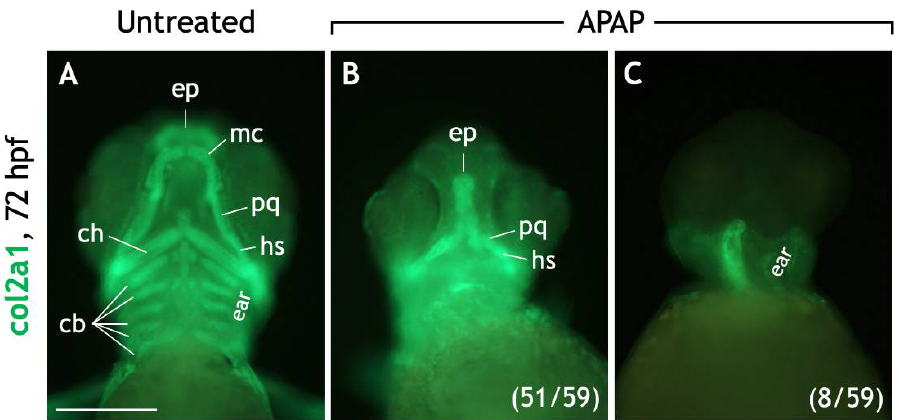
Figure 7. Most APAP-treated embryos express collagen type II, a marker for differentiated cartilage, in the craniofacial region. ( A – C ) Ventral views of 72-hpf embryos processed for col2a1